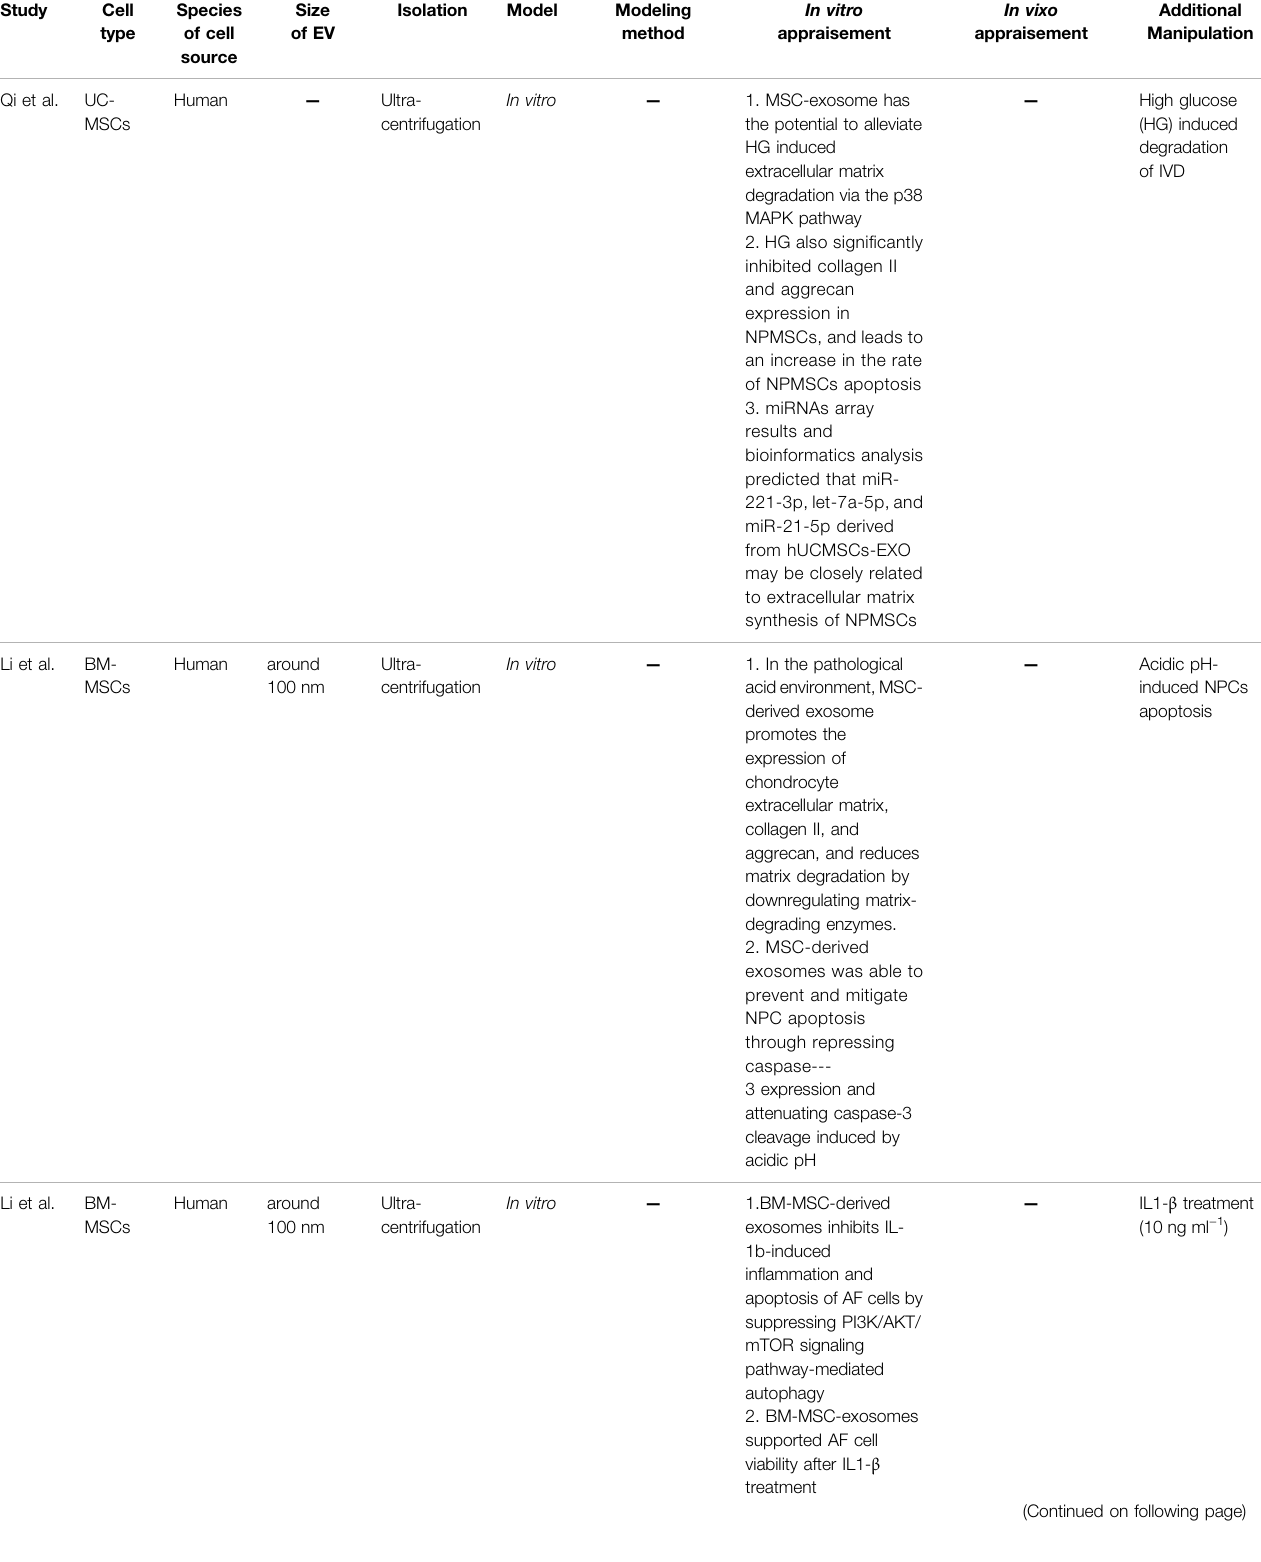
TABLE 2 | Pre-clinical studies investigating the therapeutic potential of stem cell-derived exosomes on IVDD.